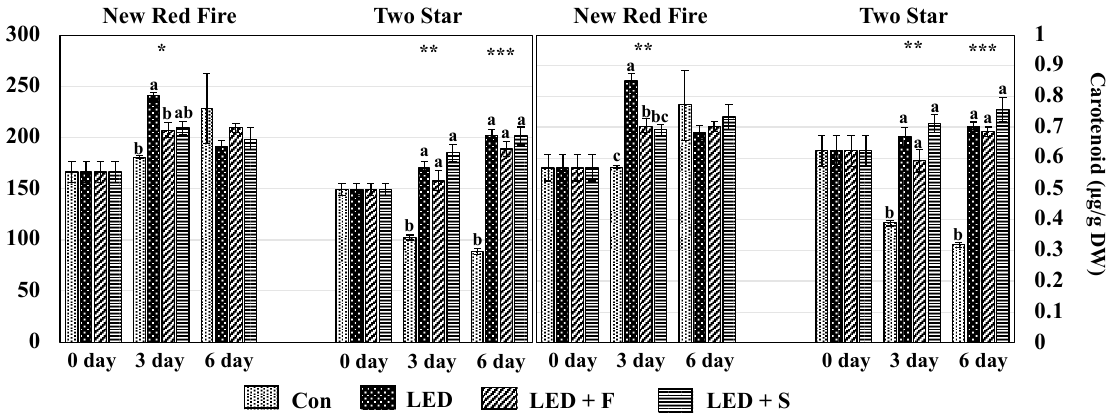
Figure 1. Total chlorophyll and carotenoid concentrations of lettuce varieties, ‘New Red Fire’ and ‘Two Star’, subjected to supplemental UV-A radiation. Treatments included LEDs, LEDs + focus lens (LED + F), LEDs + scatter lens (LED + S), and control (Con). Measurements were made at 0, 3, and 6 days of treatments. Vertical bars indicate standard errors (n = 4). Bars with different letters are significantly different. Significant differences are presented at p < 0.05 (*), p < 0.01 (**), and p < 0.001